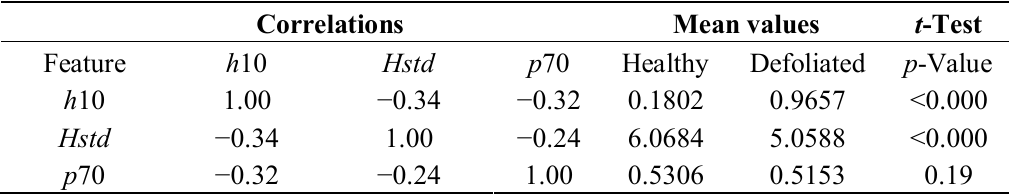
Table 4. Pearson’s correlation, mean values for healthy and defoliated trees and significance for explanatory ALS